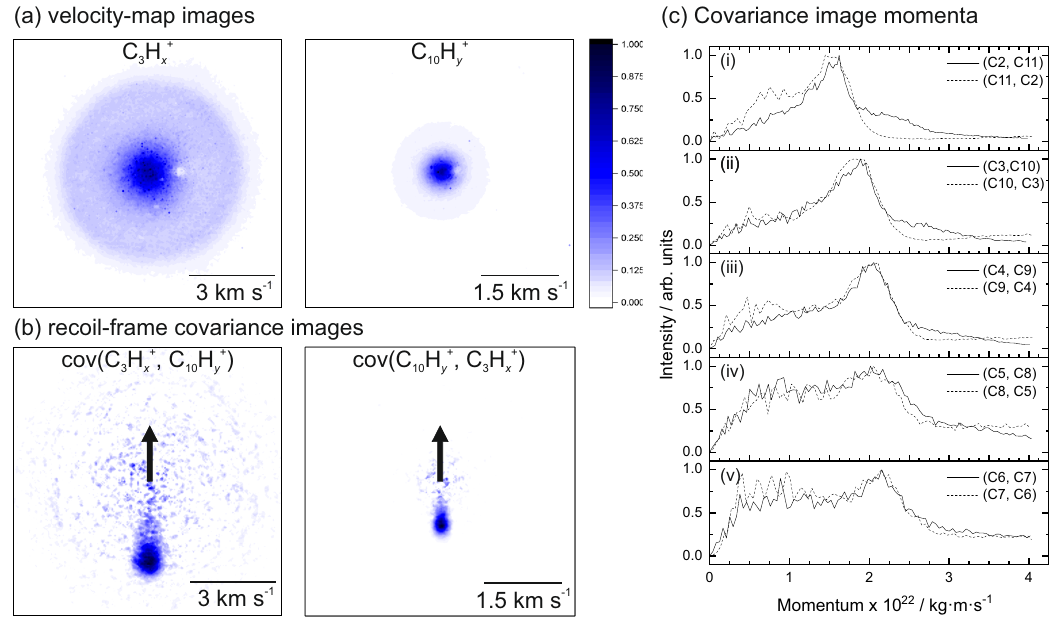
Fig. 2 Ion images, covariance images, and momentum comparisons. a Velocity-map images and b covariance map images for the C 3 H þ x and C 10 H þ y fragment ions arising from dissociative ionization of FLU, C 13 H 10 . Each image is individually normalized. The velocity-map images are presented without symmetrization or Abel-inversion to provide a better comparison to the covariance images. The small areas lacking signal near the center of the velocity- map images are attributed to damage in the MCP/phosphor detector. Black arrows in the covariance images indicate the direction of the reference ion. c Momentum pro fi les of the ion pairs resulting from the two-body dissociative ionization of fl uorene. An angular integration is performed on the covariance images, and the spatial coordinates are converted to momentum units. Cov( A, B ) refers to the covariance of ion A with B as the reference ion. Discrepancies between the plots in (i) are attributed to physical defects in the detector and background ions affecting the ion images